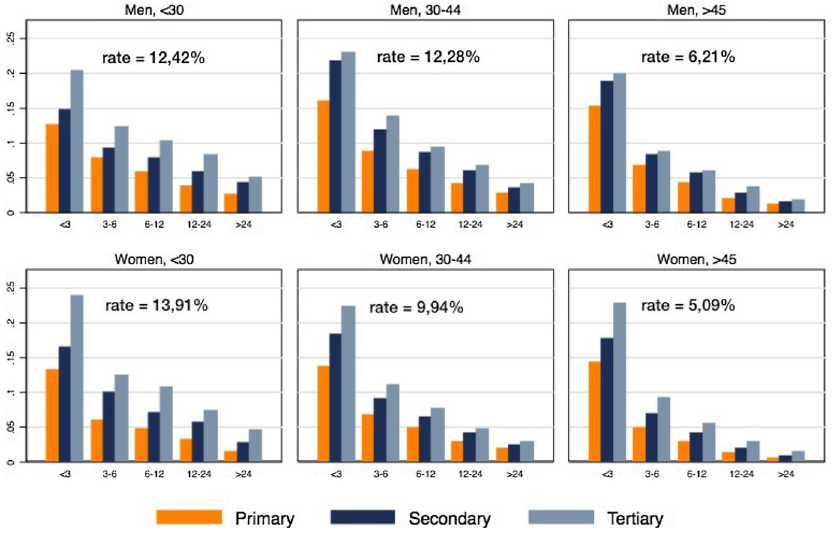
Fig. 4 Exit rates in to the labour market of non-MIP perceivers in Basque Country, 2015. Axes: gender, age, unemployment duration (months), educational level. Source : Own elaboration. Lanbide